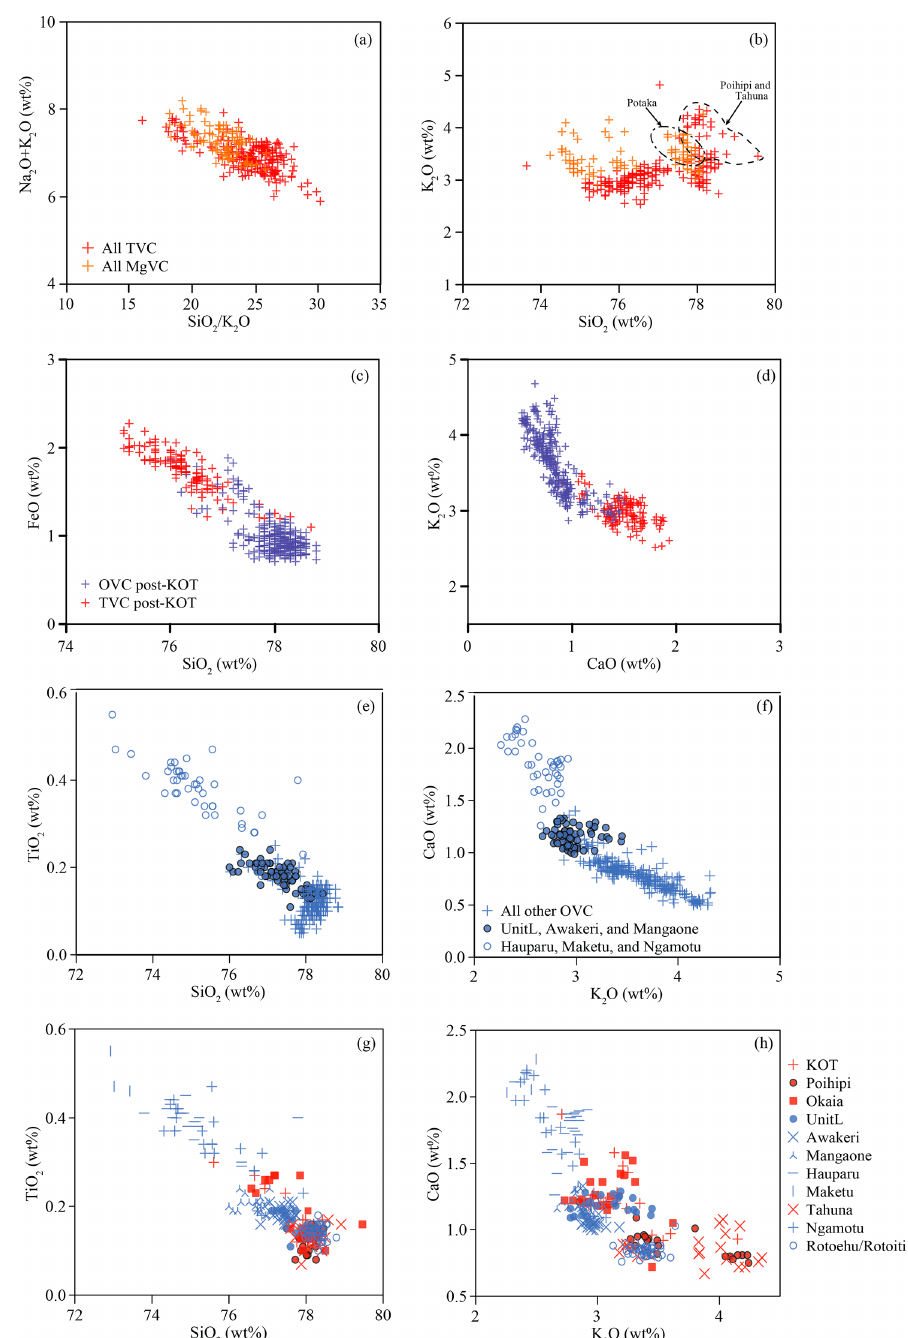
Figure 11. Major-element biplots to distinguish between caldera sources of tephras based on their glass major-element compositions (pre- sented on a normalised basis; total iron is expressed as FeO): (a) and (b) show a comparison between all glass-shard analyses for the TVC- and MgVC-sourced tephras; (c) and (d) indicate the distinction in glass compositional signature for the eruptives from the OVC and TVC that post-date the Kawakawa/Oruanui (KOT) eruption; (e) and (f) plots distinguish the glass analyses for tephra from the OVC into component eruptive time periods, with tephra from the Mangaone Subgroup (Jurado-Chichay and Walker, 2000; Smith et al., 2002) distinguishable from all other tephra from the OVC; (g) and (h) show the similarity in the geochemical compositions of glass of the tephras from the OVC and TVC for the eruptions prior to, and including, the KOT eruption. Colours are consistent for each caldera source; symbols are representative of different groups of tephra defined in the keys for each set of